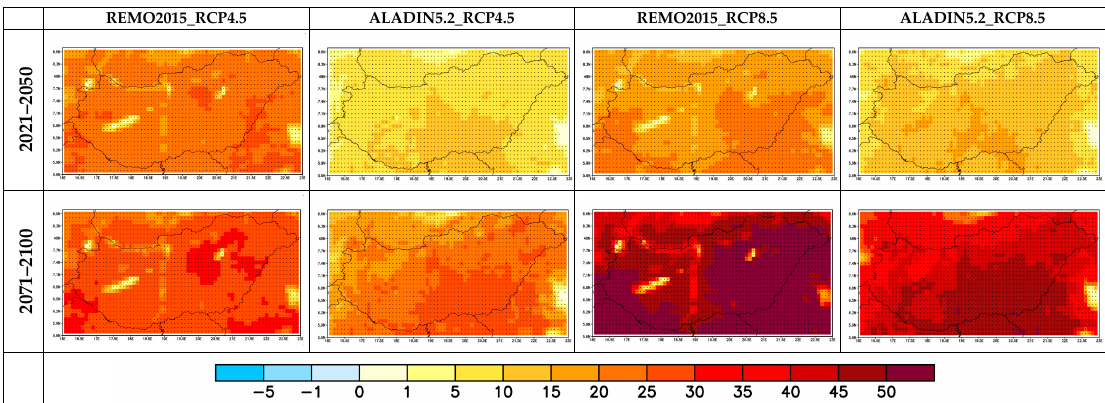
Figure 14. Change in the annual number of extremely hot days (days) in Hungary for 2071–2100 based on the ALADIN5.2 and REMO2015 simulations. Reference period: 1971–2000. Atmosphere 2023 , 14 , x FOR PEER REVIEW